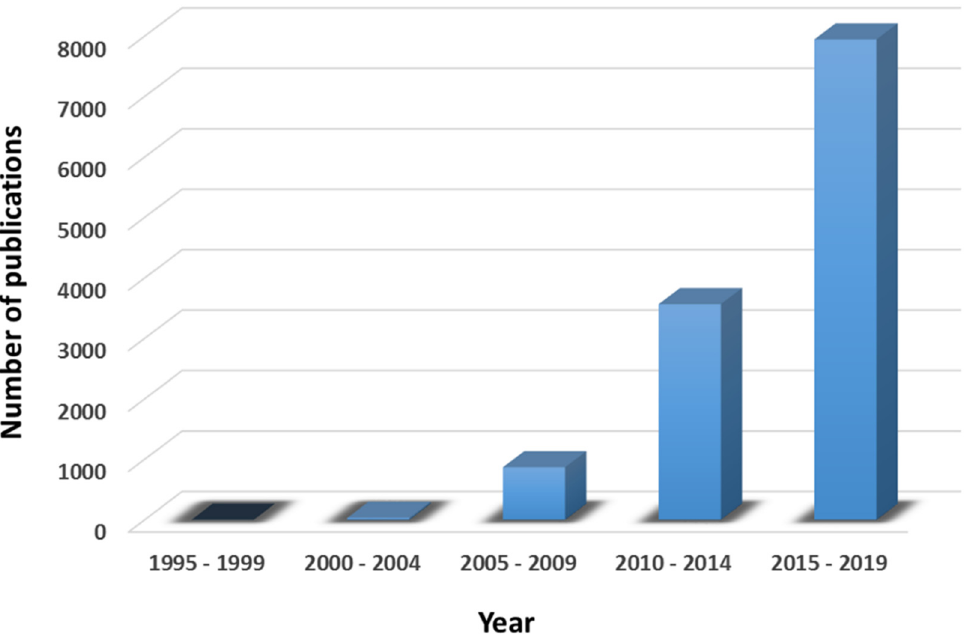
Figure 1. Number of peer-reviewed publications in the field of nanomedicine in Web of Science divided in periods of 5 years.